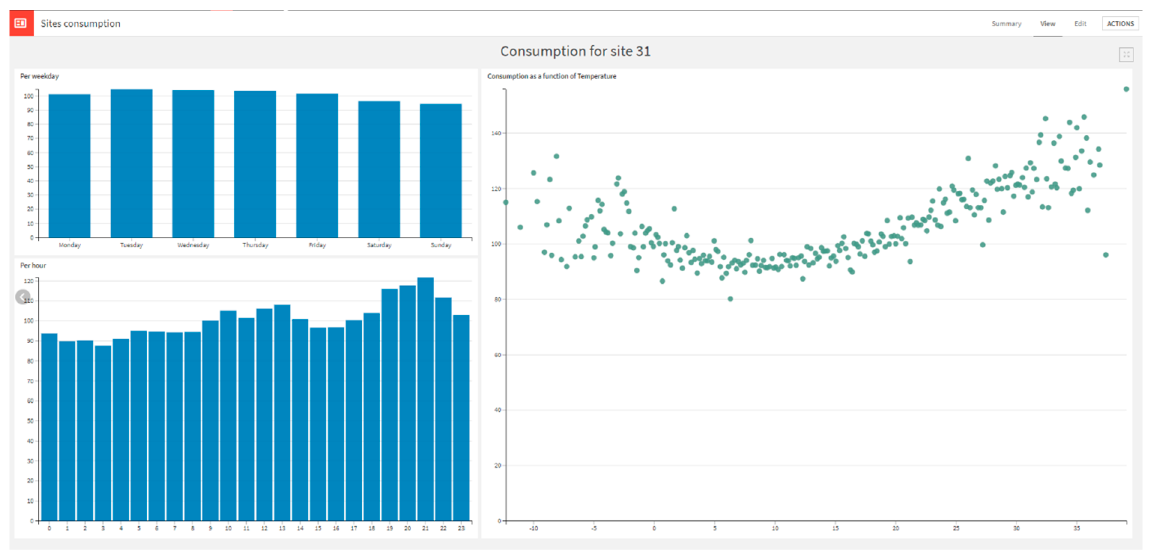
Figure 15. Energy consumption trend for another hotel.